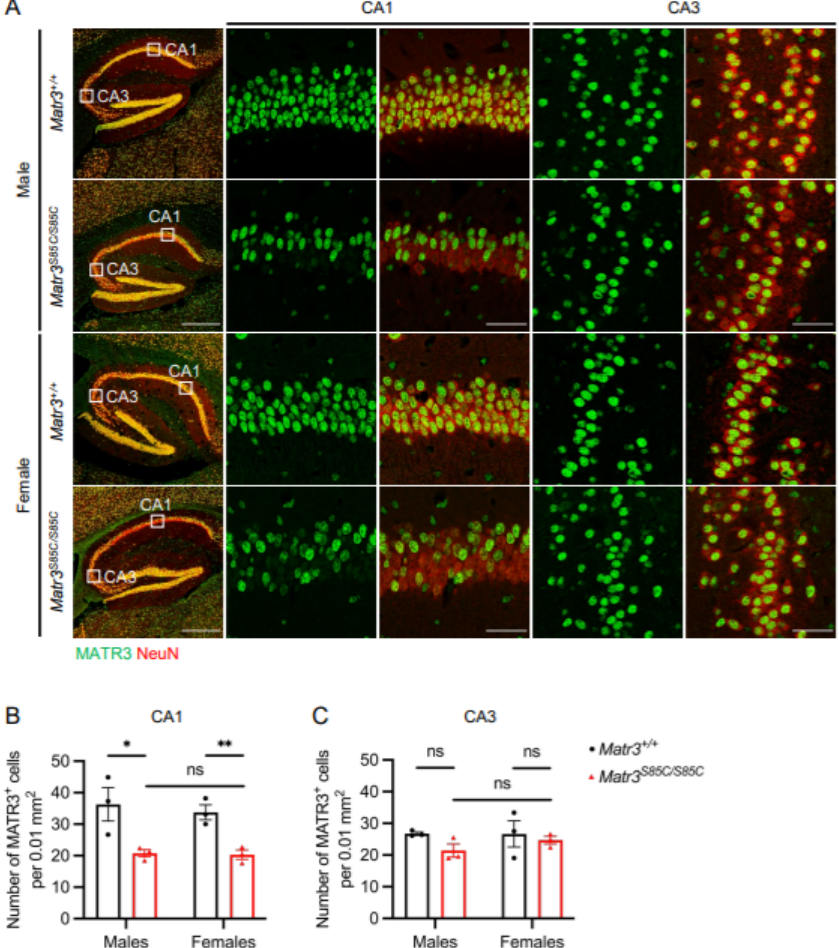
Figure 4. MATR3 loss in the hippocampal CA1 region of Matr3 S85C/S85C mice. ( A ) Representative images of the entire hippocampus at 60 weeks with the scale bar denoting 500 µ m (images on the left column). Representative enlarged images of the CA1 and CA3 with the scale bar denoting 50 µ m (images on the right four columns). Quantification of the number of MATR3 + cells in the ( B ) CA1 (males: n = 3 Matr3 +/+ , 3 Matr3 S85C/S85C ; females: n = 3 Matr3 +/+ , 3 Matr3 S85C/S85C ) and ( C ) CA3 (males: n = 3 Matr3 +/+ , 3 Matr3 S85C/S85C ; females: n = 3 Matr3 +/+ , 3 Matr3 S85C/S85C ). Bar graph heights depict mean ± SEM, with each datapoint representing an animal. * p < 0.05, ** p < 0.01, ns = not significant.